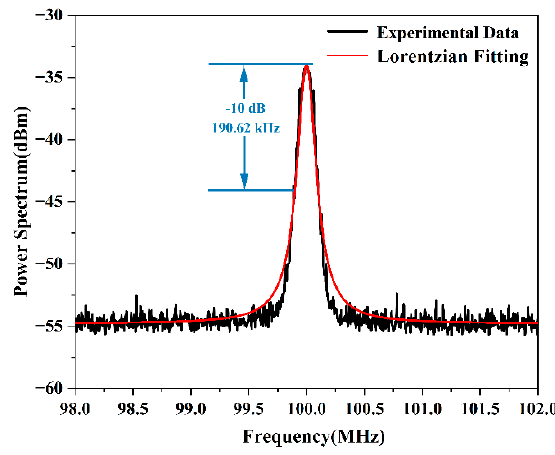
Figure 4. Plot of the experimentally obtained PSD using a 50 km long delay fiber.